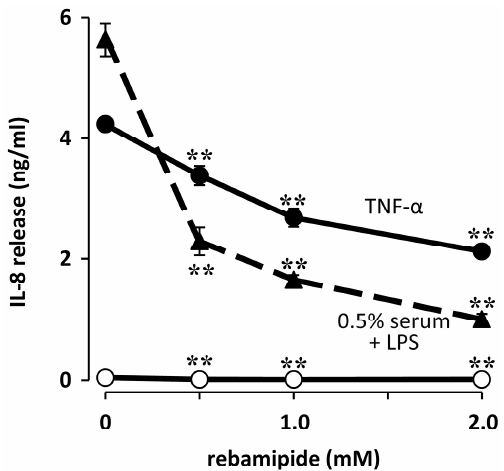
Figure 4. Effect of rebamipide on IL-8 release induced by LPS in human corneal fibroblasts. Cells were incubated first for 1 h with the indicated concentrations of rebamipide and then for 48 h in the additional absence (open circles) or presence either of LPS (100 ng/mL, triangles) plus 0.5% human serum or of tumor necrosis factor- α (TNF- α ) (10 ng/mL, closed circles), after which the concentration of IL-8 in culture supernatants was determined. Data are means ± SEM of quadruplicates from a representative experiment. ** p < 0.01 versus the corresponding value for cells incubated without rebamipide. Reprinted with permission from [42].